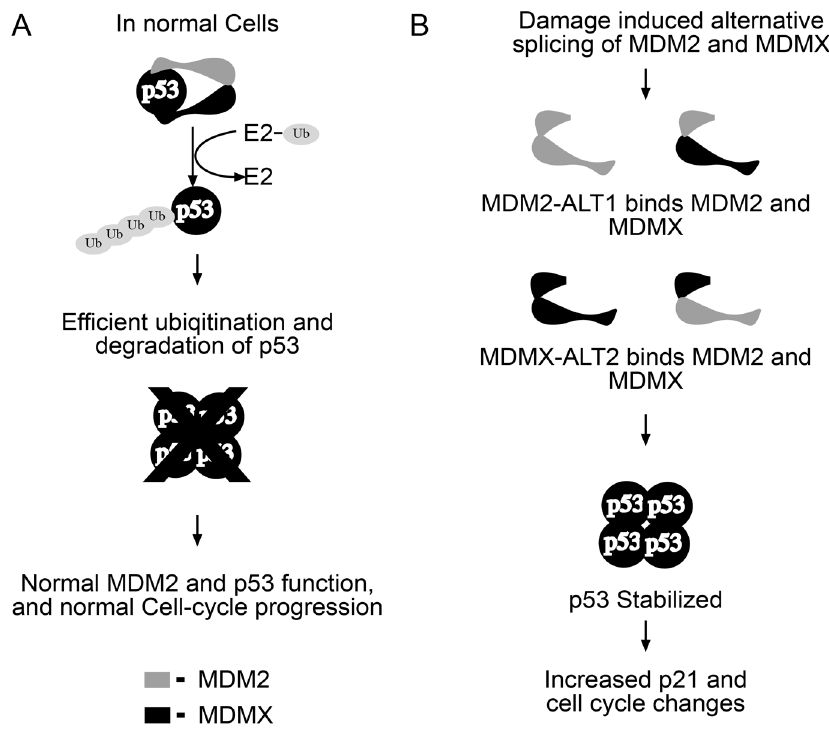
Figure 5. Proposed model: MDM2-ALT1 and MDMX-ALT2 antagonize their full-length counterparts and lead to p53 stabilization. A. Under normal conditions, MDM2 and MDMX function to maintain low levels of p53 (via ubiquitination and subsequent degradation) and curb its transcriptional activity by binding p53. This helps maintain homeostasis and normal cellular functions including cell cycle progression. B. Under genotoxic stress, alternative splice forms MDM2-ALT1 and MDMX-ALT2 interact with the full-length MDM proteins and interfere in their p53- regulatory functions. This leads to the stabilization and upregulation of p53 levels and also the activation of p53 transcriptional targets leading to changes in cell cycle